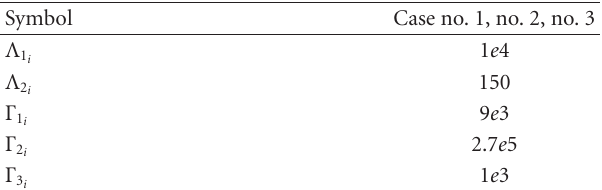
Table 3: parameters of the positioning and sti ff ness actuators fast controllers used in the